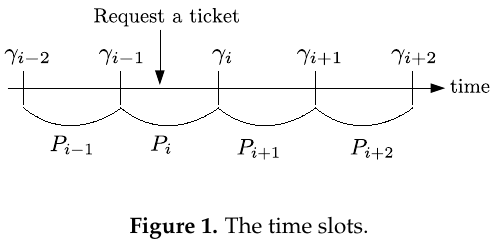
Figure 1. The time slots.